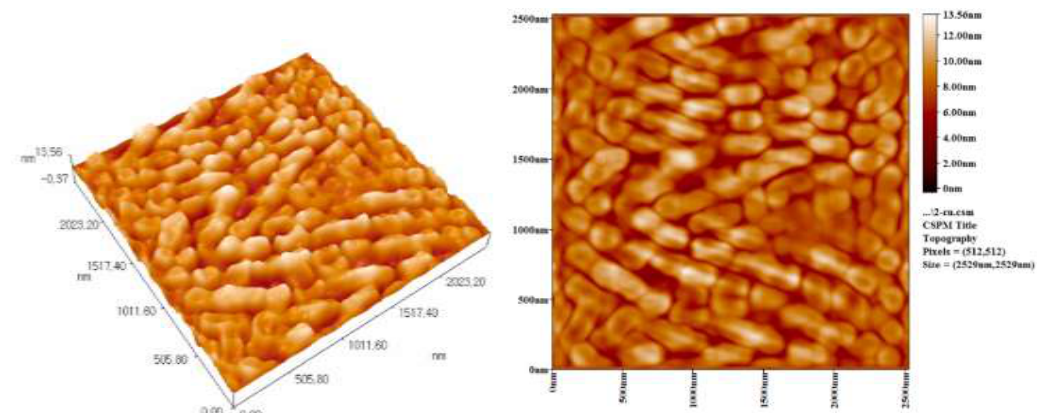
Fig.4: AFM Surface scans of copper surface after LST, a. (3D) View. b. (2D) View section analysis showing roughness parameter.